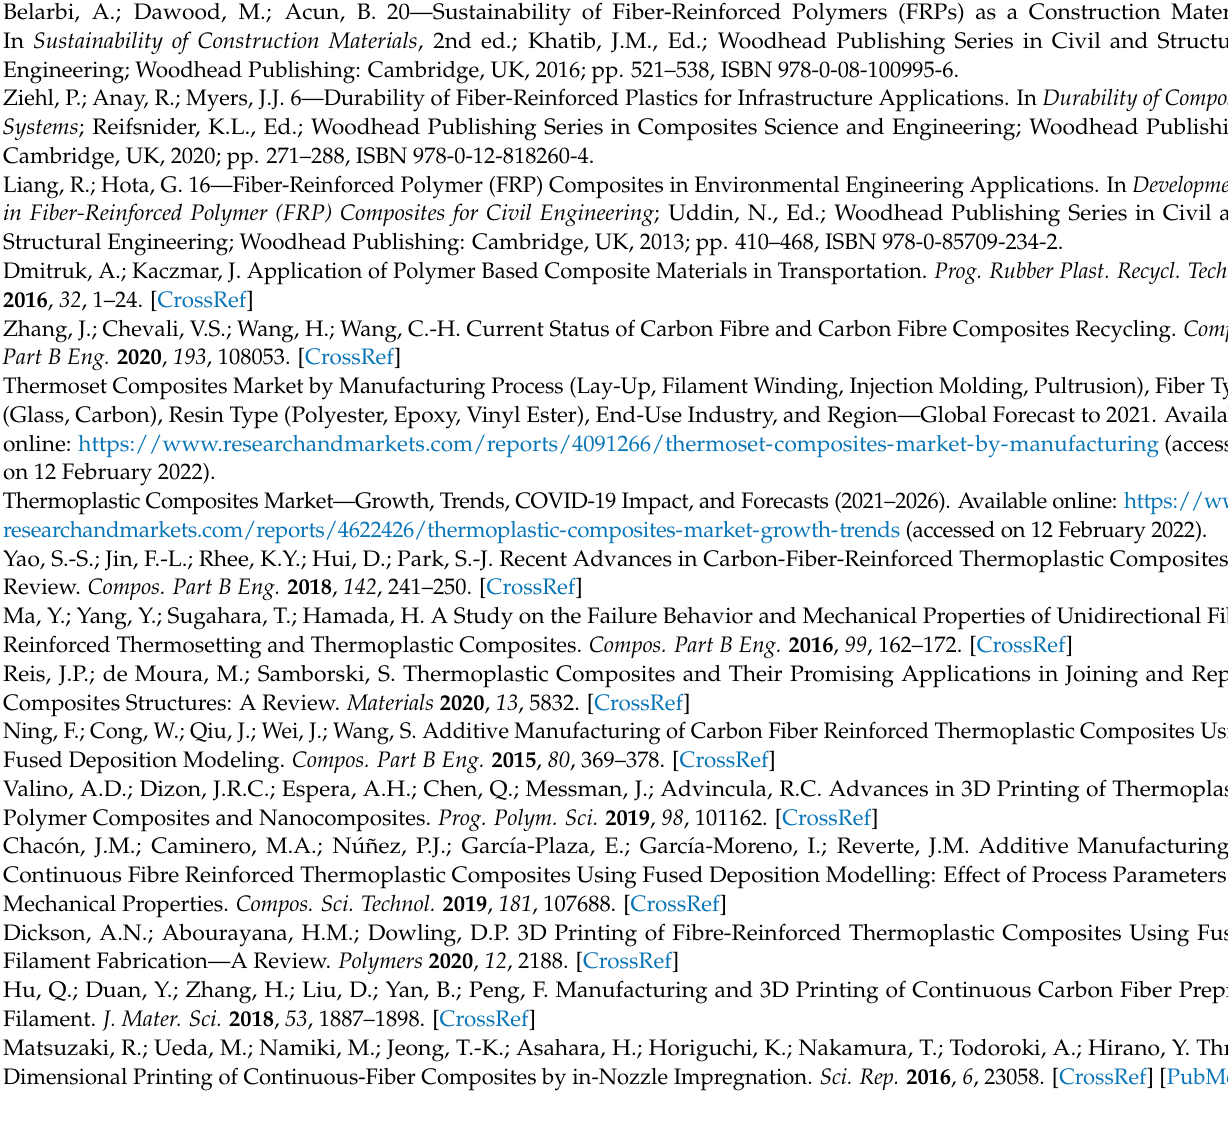
Figure A12. Contour plot for v and h according to the ML-based prediction model.